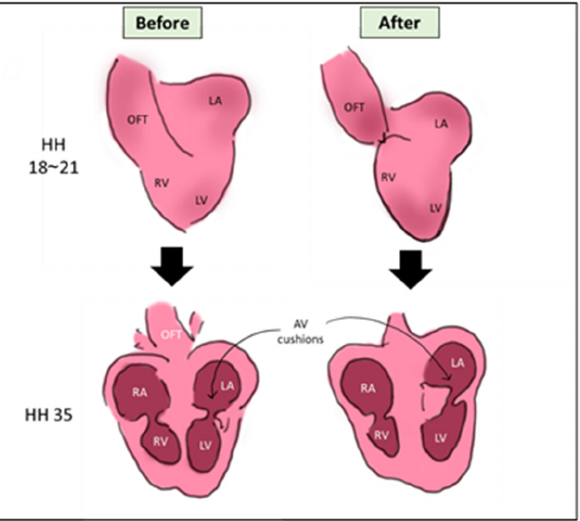
Figure 3. A schematic showing the OTB surgery. The surgery is done on HH18~HH21, where a suture is banded around the OFT. The main morphological output of VVL is the defected looping and cushion development [56]. OFT: outflow tract, LA: left atrium, RA: right atrium, LV: left ventricle, RV: right atrium, AV cushions: atrioventricular cushions, HH: Hamburger & Hamilton.